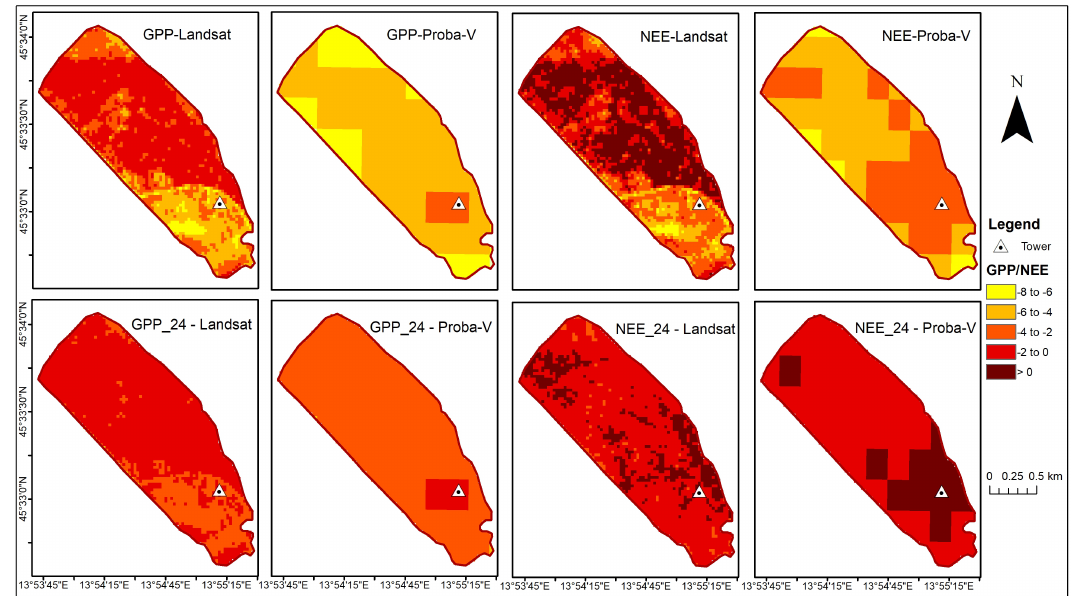
Figure 6. Maps of average midday and daily GPP and NEE estimates for the periods 2 July 2017 to 6 July 2017 (for Landsat) and 01 July 2017 to 10 July 2017 (for Proba-V), using the best models obtained for the dry phase (Table 5). The remark “_24” is used to distinguish daily from midday average fluxes.